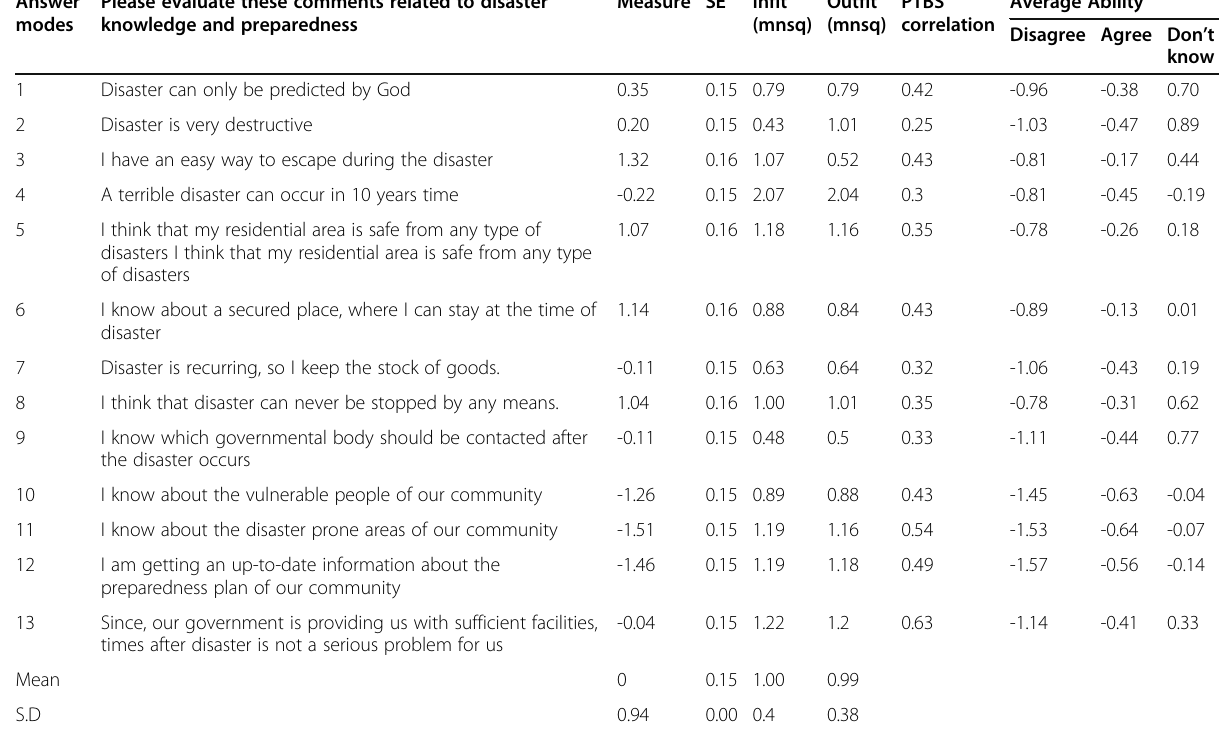
Table 4 Disaster knowledge of the people, negative correlation exists between responses of consecutive disaster-related questions Answer